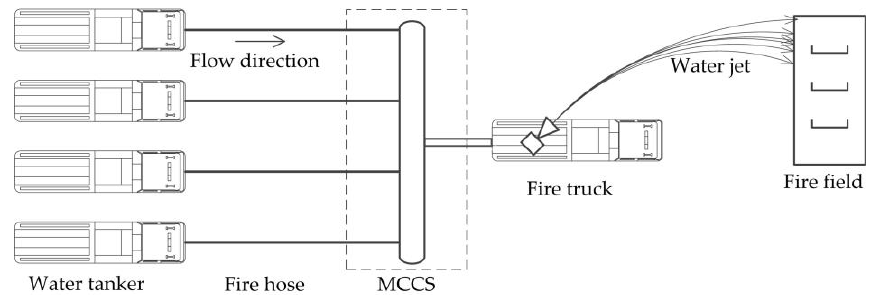
Figure 1. Mobile application of a multi-channel confluent supply (MCCS) structure in the field of fire protection.